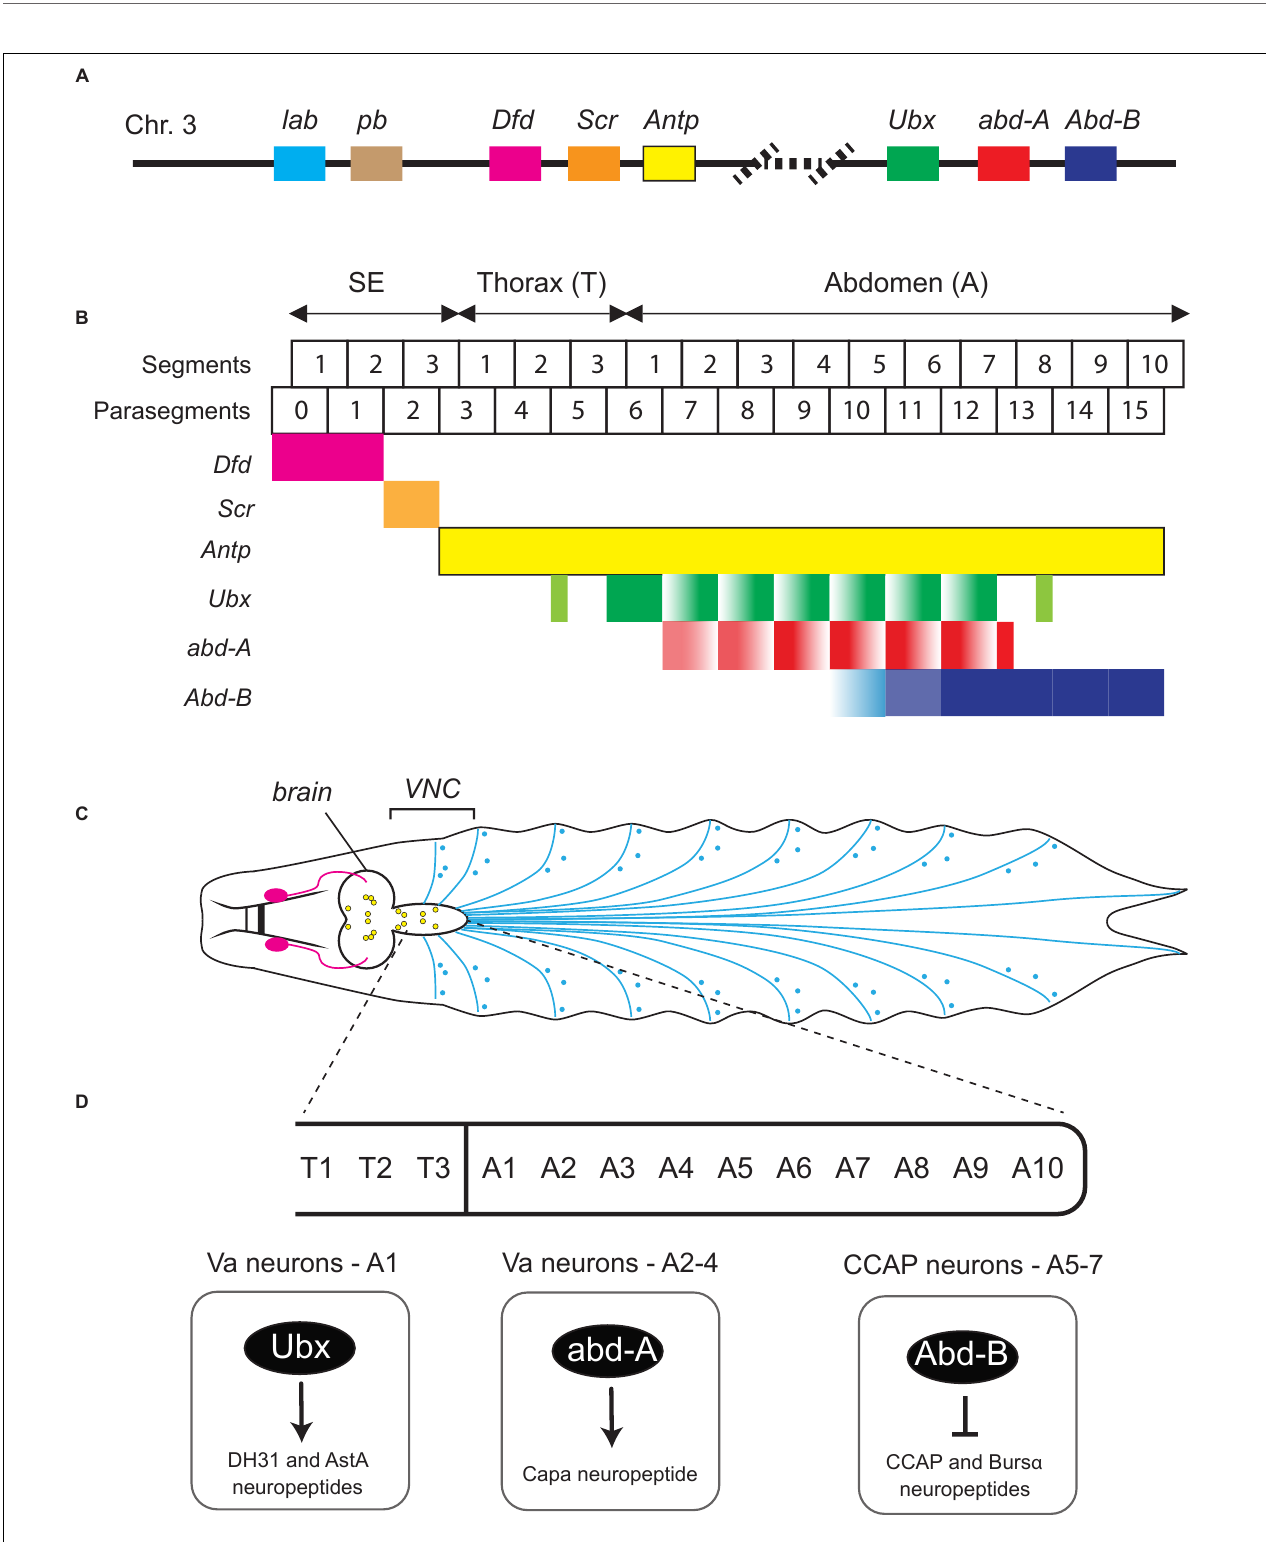
FIGURE 2 | Hox gene expression in the Drosophila nerve cord. (A) Schematic of the Drosophila Hox gene cluster. (B) Six Hox genes ( Dfd, Scr, Antp, Ubx, abd-A, Abd-B ) are expressed in the Drosophila ventral nerve cord (VNC). Their expression pattern along the A-P axis is color-coded. SE, subesophagus; Th, thorax; Ab, abdomen. Adapted from Estacio-Gomez and Diaz-Benjumea (2014). (C) Schematic of the nervous system in Drosophila larvae showing the brain, VNC, and the peripheral nervous system at the late 3rd instar stage. Adapted from Sokabe et al. (2016). (D) Examples of Drosophila Hox genes that control terminal identity features of VNC neurons. See text for